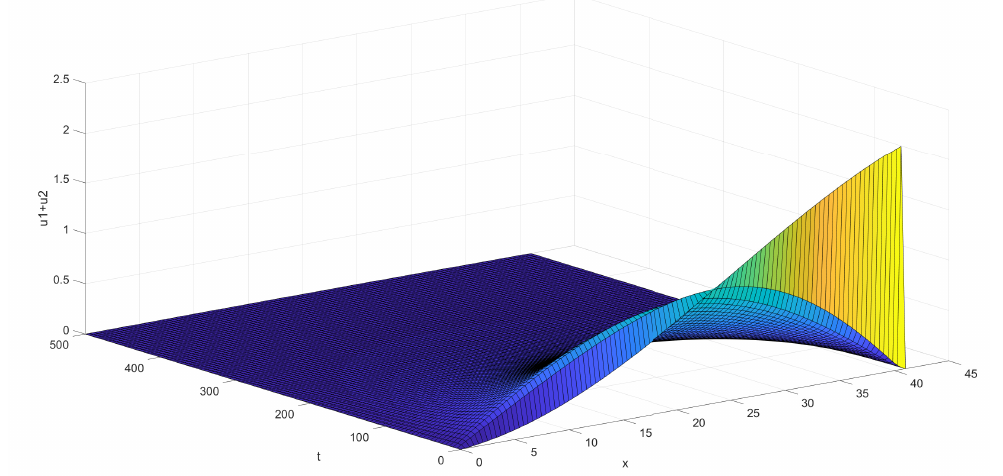
Figure 4. Decay of ticks in the case of one pair of background/control